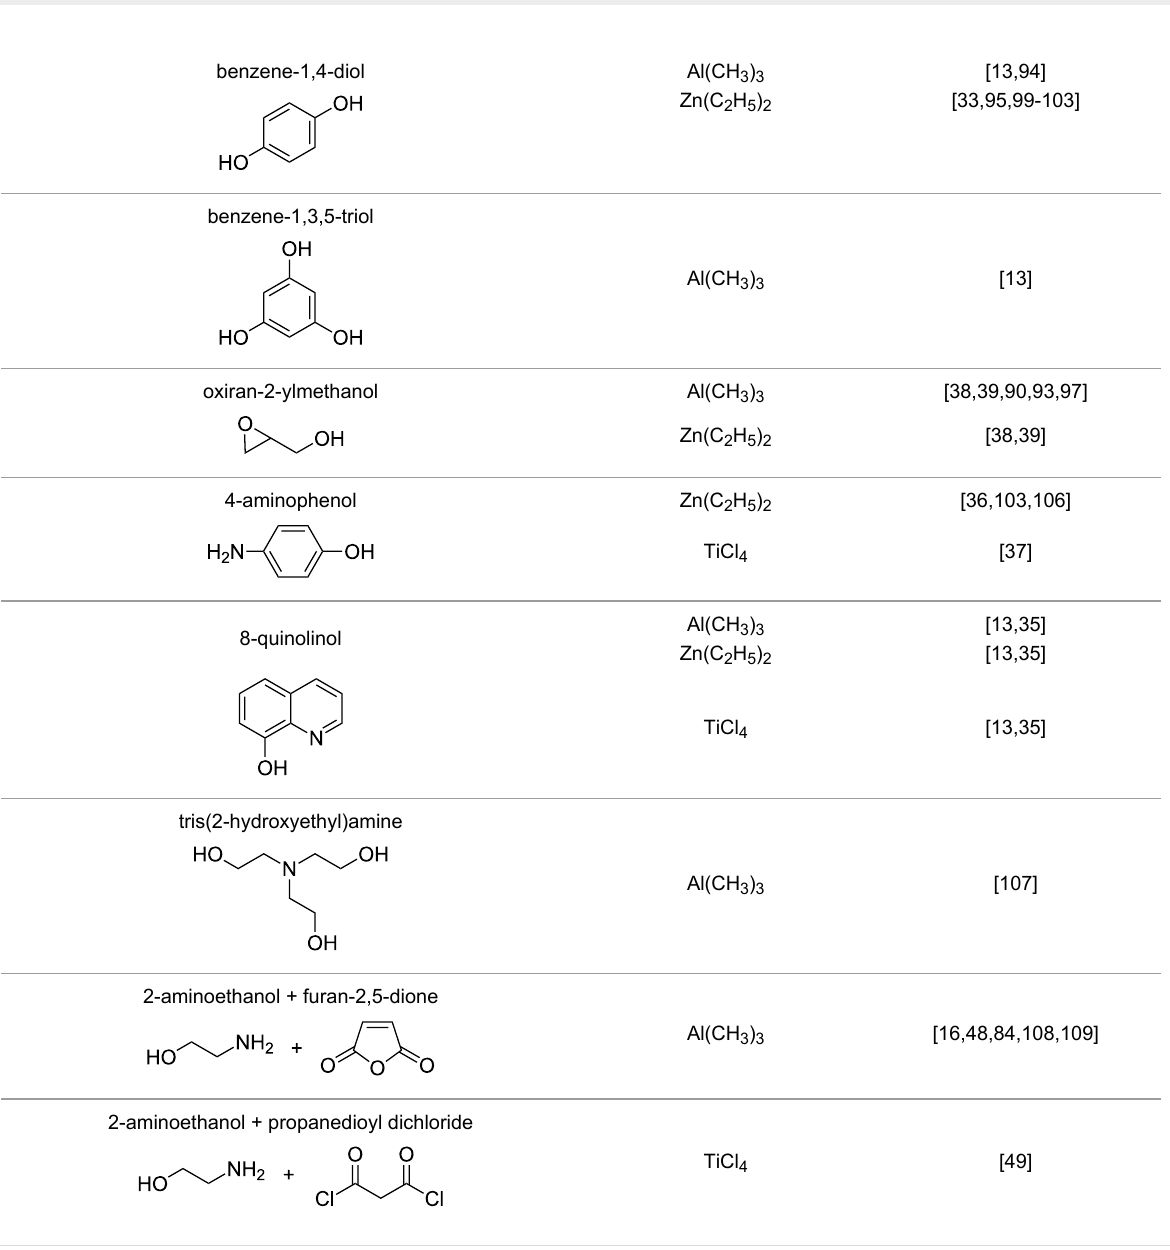
Table 11: Alcohol and phenol precursors used to deposit inorganic–organic hybrid thin films.